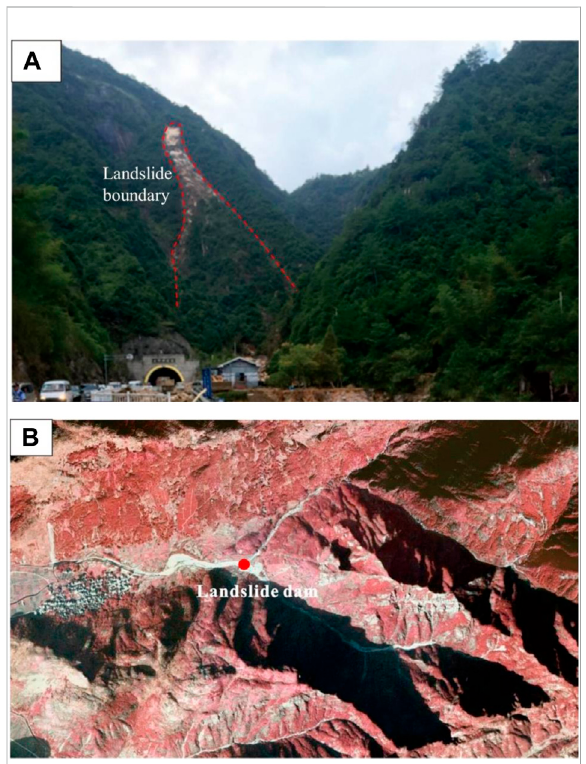
FIGURE 7 Twotypesofdisasterchaininthestudyarea. (A) Earth fl owon the slope surface from slope instability and (B) landslide dam caused by debris fl ow into a